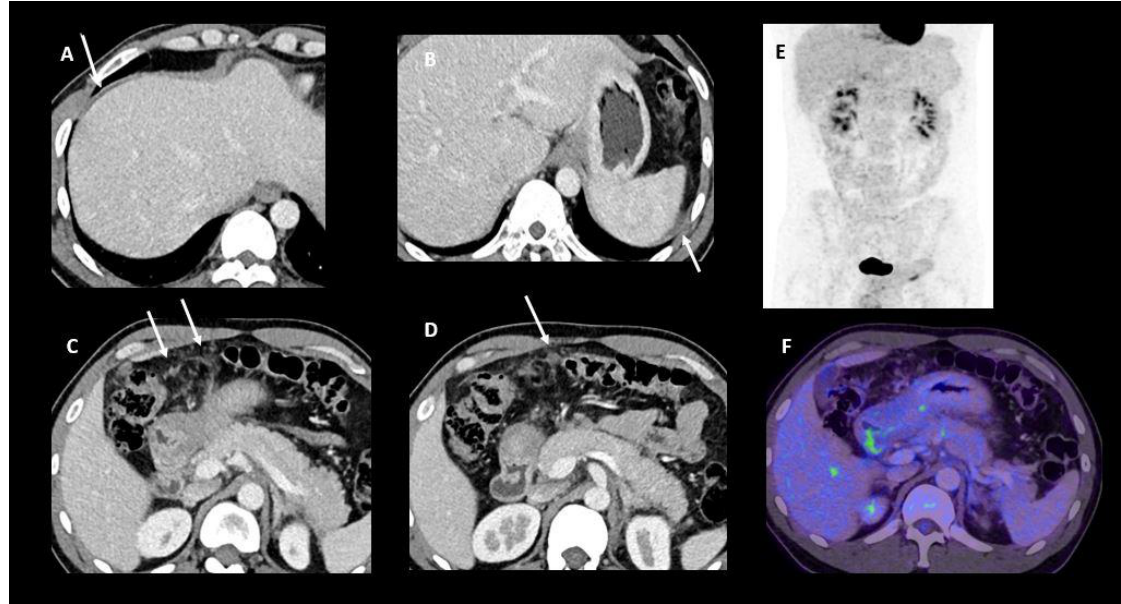
Figure 5. Contrast-enhanced FDG PET/CT performed for initial staging of a newly diagnosed diffuse-type gastric cancer with signet ring cells. Contrast-enhanced CT images ( A – D ) show a small amount of ascites around the liver and the spleen and a micronodular infiltration of the great omentum. No FDG tracer uptake was depicted on either MIP projection ( E ) or fused PET/CT image ( F ). A laparoscopic exploration confirmed the presence of a peritoneal implant located on the right and left diaphragm and around the round ligament.